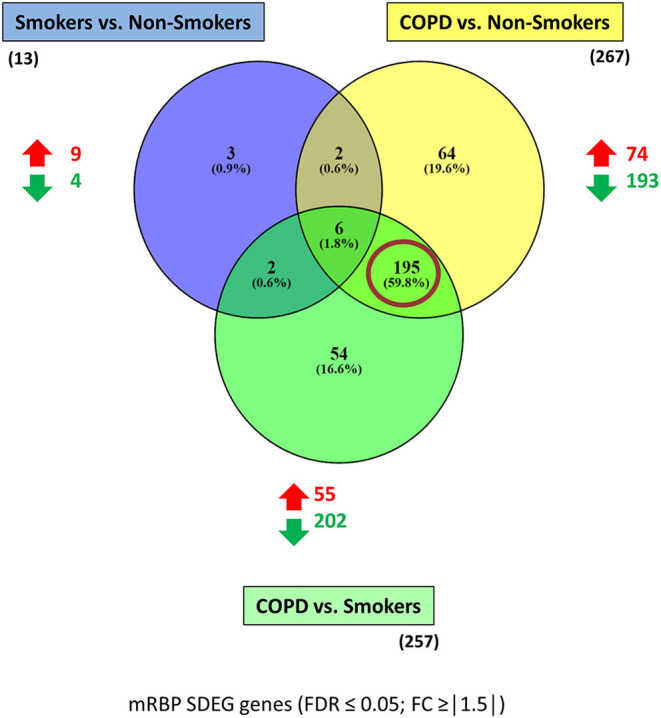
mRBP SDEG genes in small airway epithelium of stable COPD patients vs. non-smoking and smoking control subjects: unique and overlapping regulated expression. Venn diagram generated with Venny 2.1 (23), showing selective and shared mRBPs SDEG genes (FDR ≤ 0.05; FC ≥ |1.5|) among the three comparisons. The number of up-and down-regulated mRBPs for each comparison are shown by red/green arrows; the total number is indicated in parenthesis. Red circle highlights the predominant number of SDEG differentially expressed in COPD, regardless the smoking status of controls.